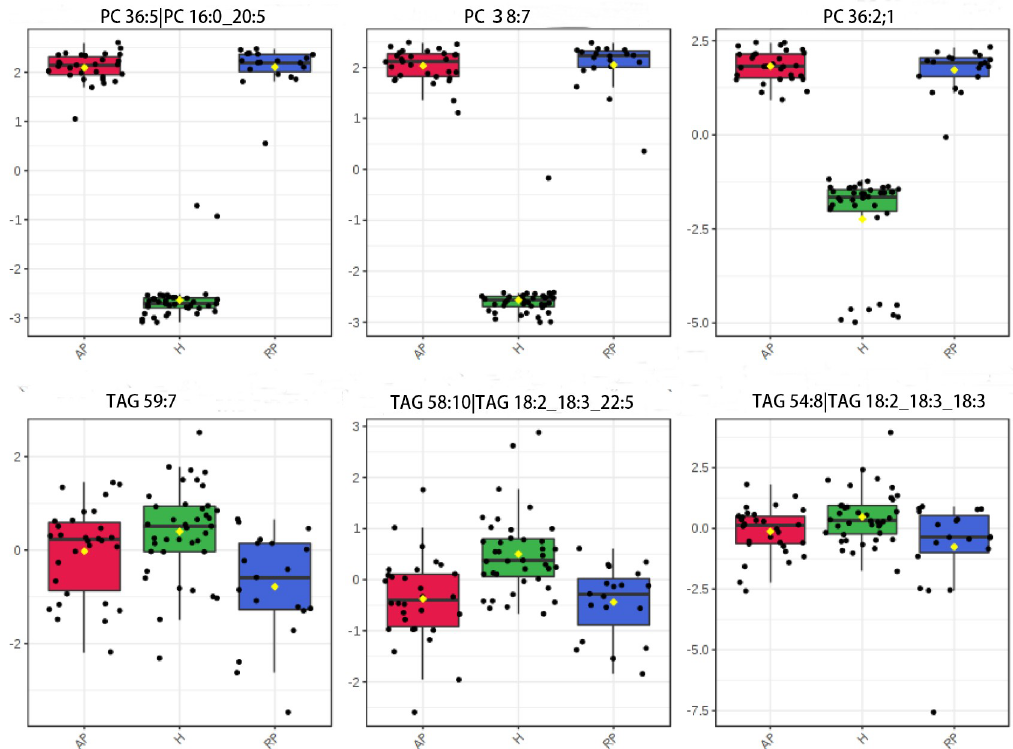
Fig 3. Relative abundances of differential metabolites in serum samples collected from patients and controls based on lipidomics. (red box: acute phase patients; blue box: recovery phase patients; green box: control group).